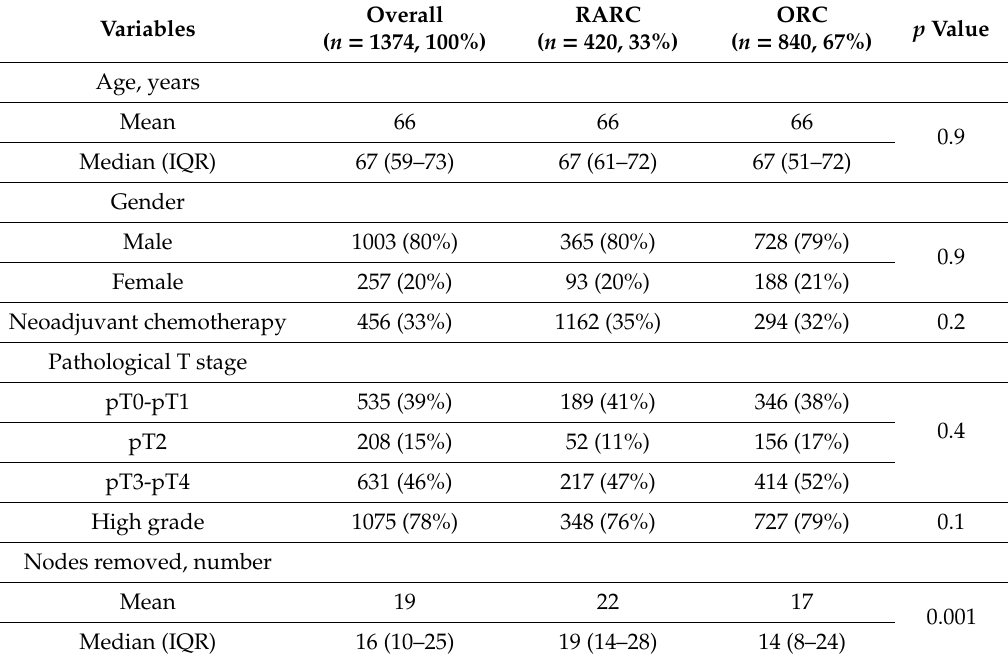
Table 2. Clinicopathologic characteristics of 1374 patients with bladder cancer treated with radical cystectomy, comparing robot assisted radical cystectomy (RARC) and open radical cystectomy (ORC) cohorts after propensity